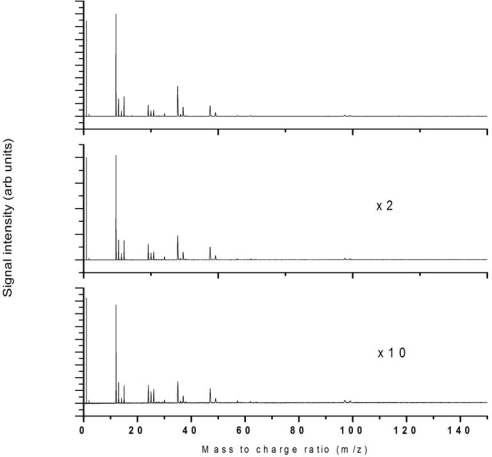
355 nm ionization using laser pulse energies of 6.8 × 1011 W/cm2, 4.6 × 1011 W/cm2 and 2.3 × 1011 W/cm2.